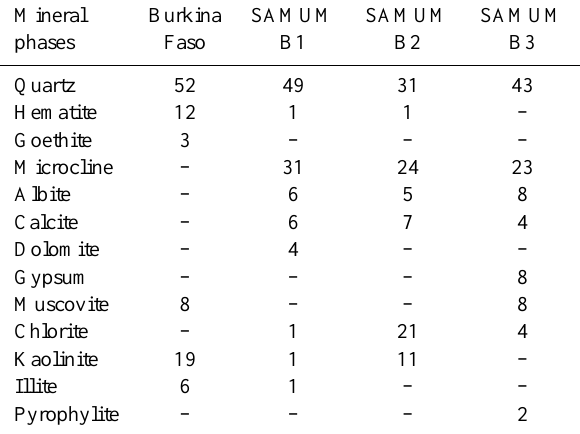
Table 3 summarises the results from the XRD bulk anal- yses of the four investigated soil samples. The three SA- MUM soil samples have a similar composition, with a quartz content of 31–49 wt % and 29–37 wt % of the feldspars albite and microcline. The lower quartz content of the SAMUM B2 sample is compensated by a higher amount of the clay min- erals chlorite and kaolinite. In each sample, the iron oxide content (hematite and/or goethite) does not exceed 1 wt %. In contrast, the Burkina Faso sample shows a very high content of iron oxides (15 wt %) with a hematite to goethite ratio of 4:1. The other dominant mineral phases are quartz (52 wt %), muscovite (8 wt %), as well as the clay minerals kaolinite and illite (19 and 6 wt %, respectively). Compared to the